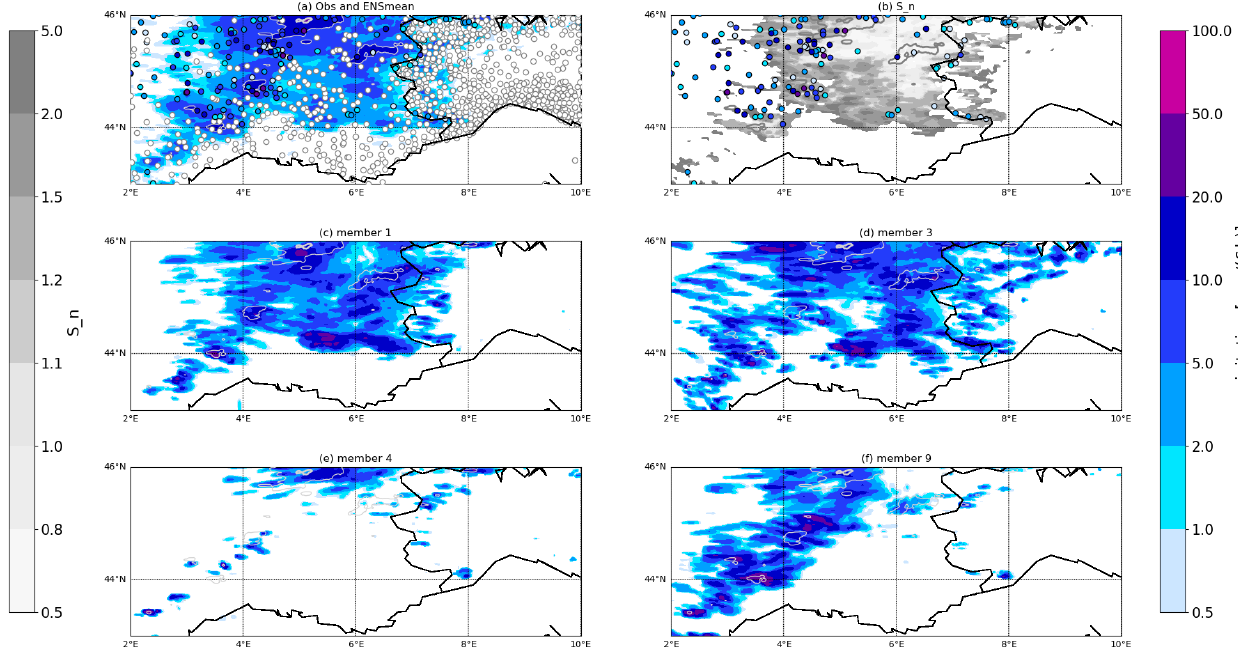
Figure 8. Same as Fig. 7, but for 11 September 18:00UTC (initialized 11 September